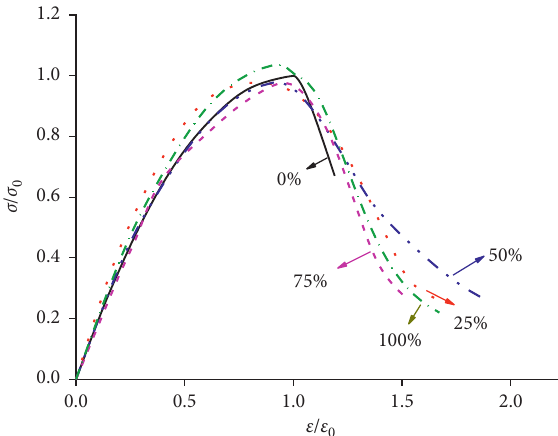
c / f cu fitting curves.